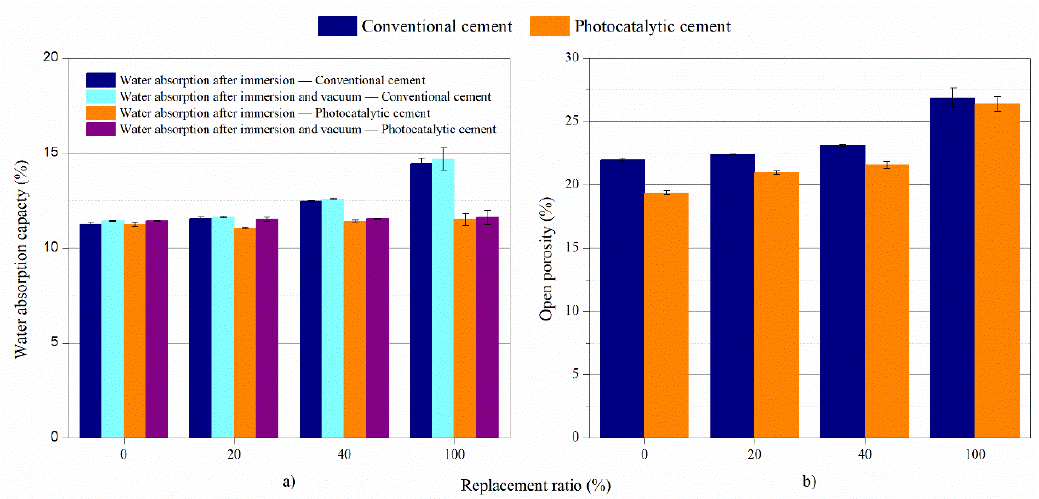
Figure 6. Comparison of results for ( a ) water absorption capacity and ( b ) open porosity.